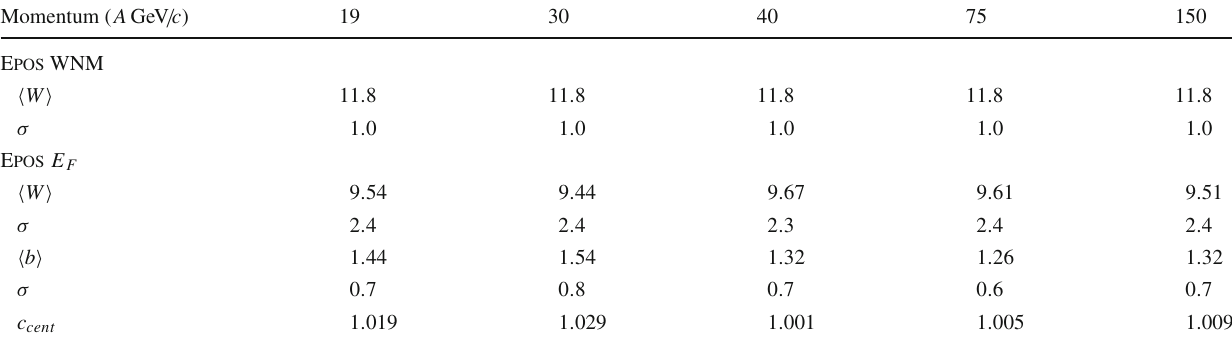
Table2 Averagenumberofwoundednucleons (cid:4) W (cid:5) andaverageimpact parameter (cid:4) b (cid:5) in the 5% most central Be + Be collisions estimated from simulations using the Epos [25] model. The values of σ denote the